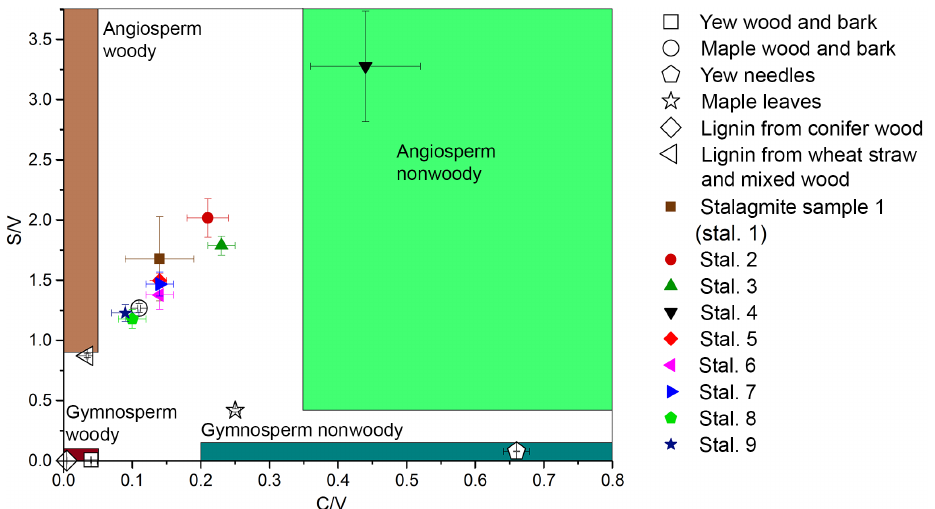
Figure 6. Lignin oxidation parameters S / V vs. C / V of different real samples and regions for different sample types defined by Hedges and Mann in